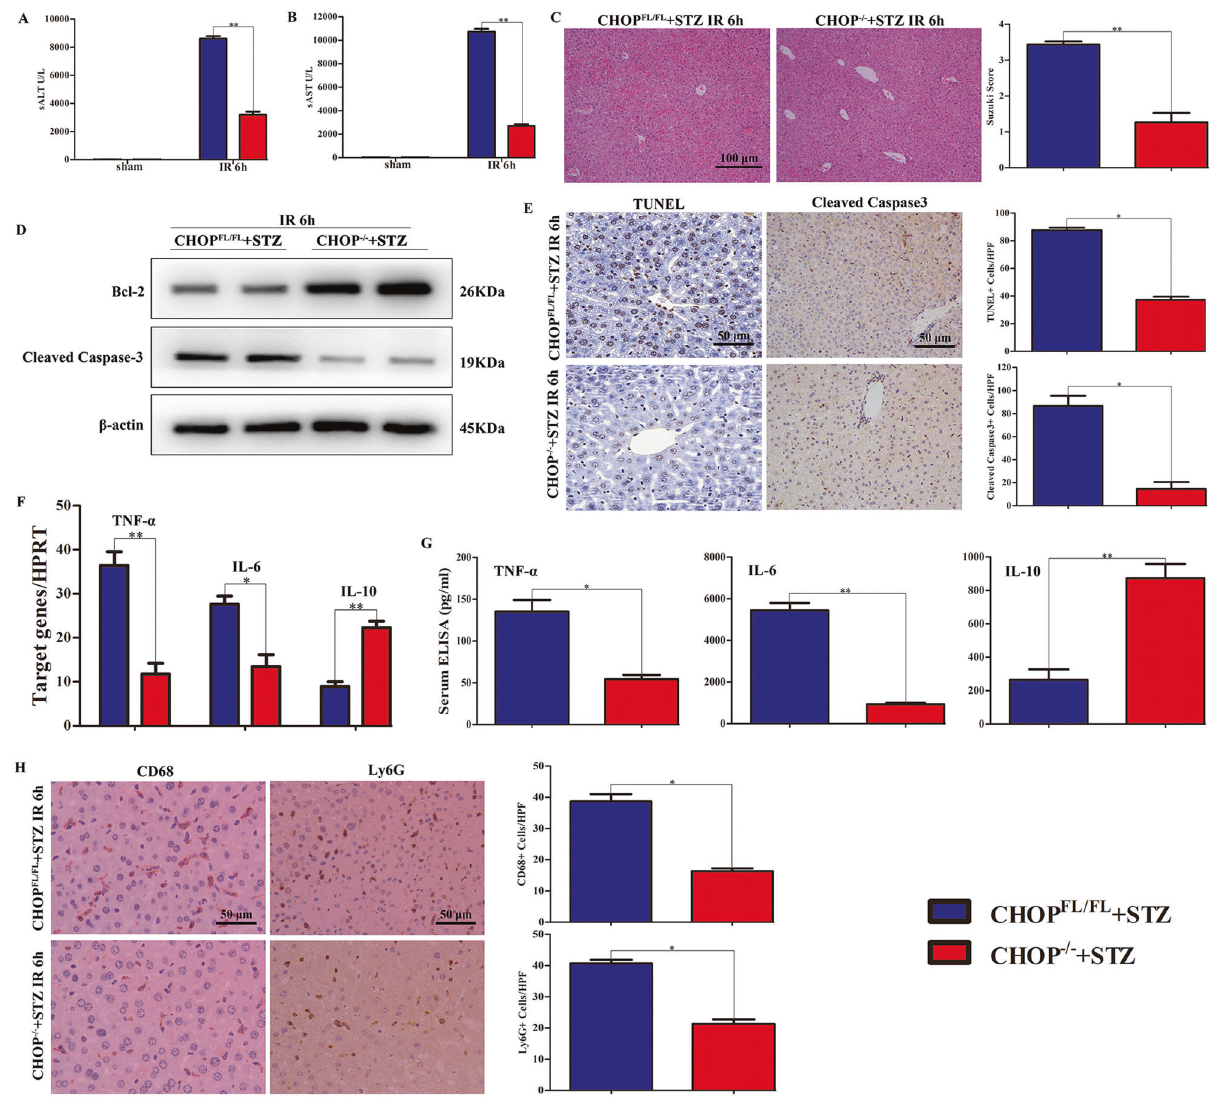
Fig. 4 CHOP de fi ciency alleviated hyperglycemia-exacerbated liver injury and TLR4-mediated innate immune responses after IR. A , B Liver function was evaluated by the value of sALT and sAST. C Histopathologic analysis of livers at 6 h after reperfusion, and the severity of liver IRI was judged according to Suzuki ’ s histological grading. D Protein expression of Bcl-2 and Cleaved caspase-3 in CHOP − / − and WT diabetic mouse ischemic livers was detected using western blot. E Apoptosis was evaluated in CHOP − / − and WT diabetic mouse ischemic livers by immunohistological staining with anti-cleaved caspase-3 (×200), and representative TUNEL-stained ischemic liver lobes (magni fi cation ×400). TUNEL + cells were recorded based on positive cell numbers/area. Cytokines level of liver and serum were examined through qRT-PCR ( F ) and ELISA ( G ), respectively. H CD68 and Ly6G staining of ischemic liver lobes (×200). Data are representative of three independent assays with similar results. * P < 0.05, ** P <